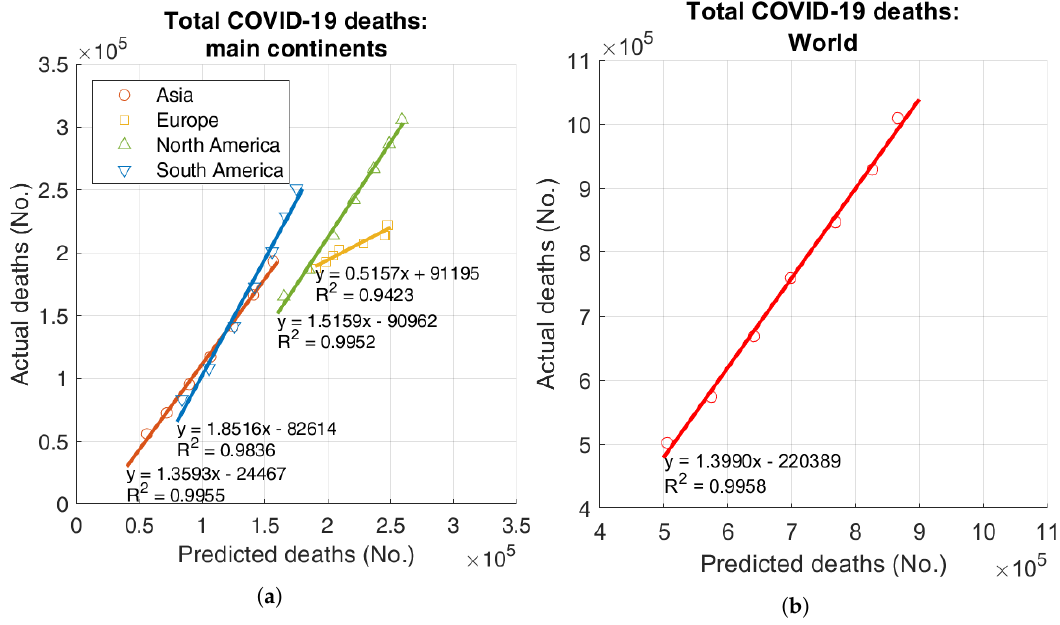
Figure 2. Actual vs. predicted total deaths: ( a ) main continents, ( b )